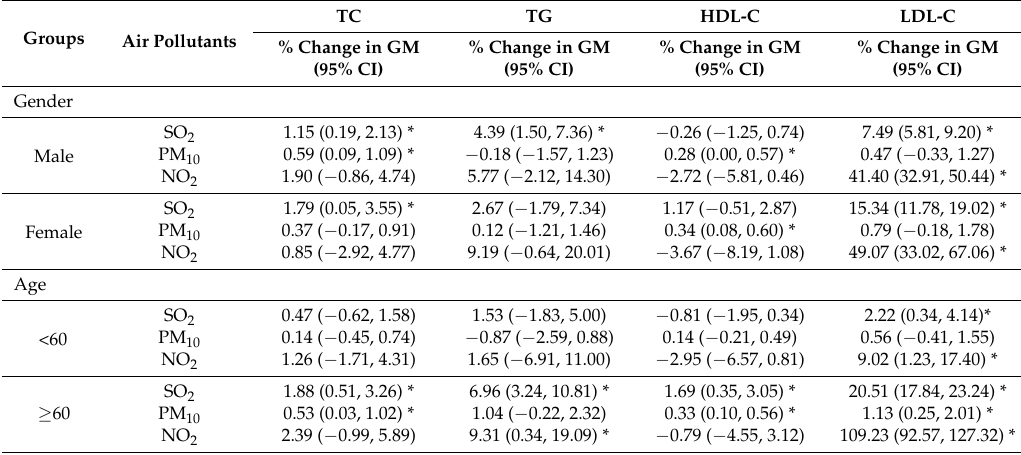
Table 3. Percent change in GM of TC, TG, HDL-C and LDL-C per 10 µ g/m 3 increase in air pollutants among type 2 diabetes patients in different groups.